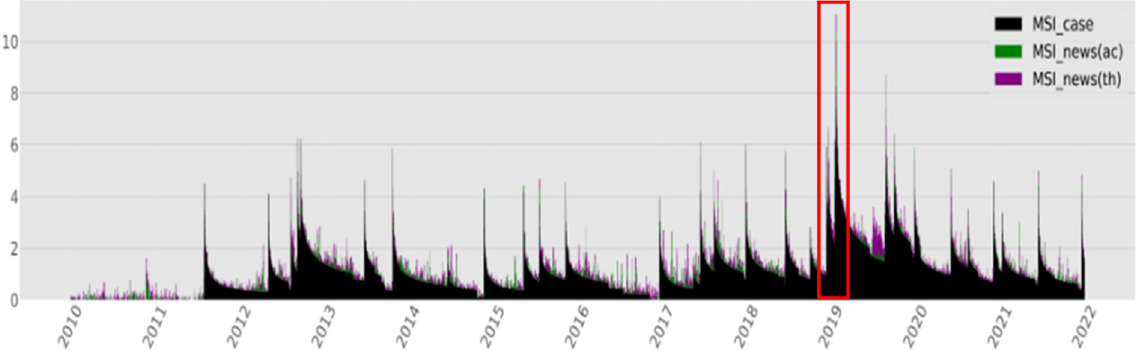
Figure 11. Military Security Index of Japan (‘10 ∼ ’21).